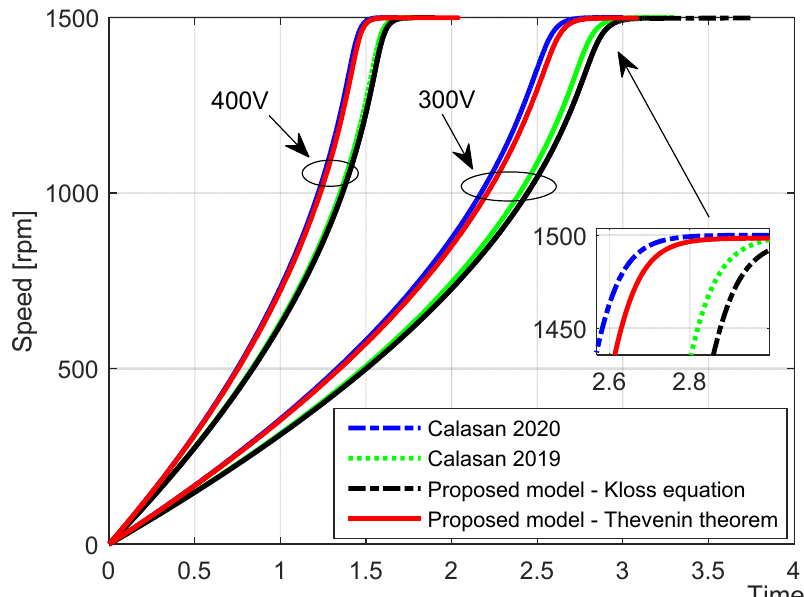
Figure 2. Impact of variation of the supply voltage on the speed-time curve during no-load direct startup ( J = 9.4 kgm 2 and B = 0.1).